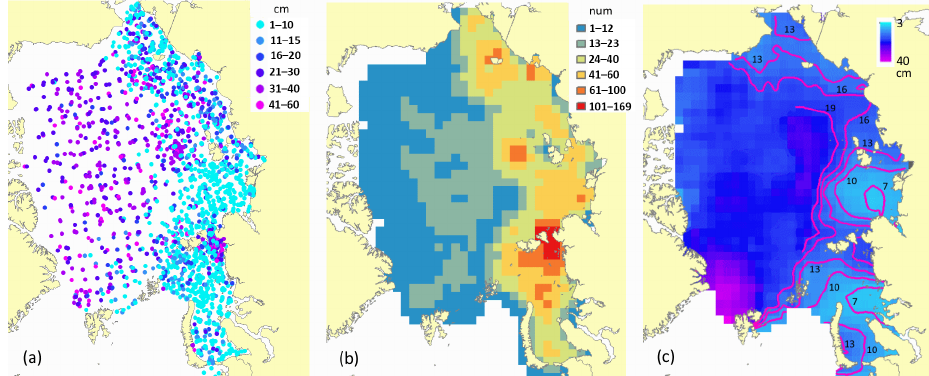
Figure 5. (a) Spatial distribution of measured snow depth on the level ice around Sever landing sites, MAM months, 1959–1988. (b) Number of point measurements used in gridding, grid cell is 100 × 100km. (c) Contour lines of the snow depth in the marginal seas produced using observations shown in panel (a) . Snow depth is in